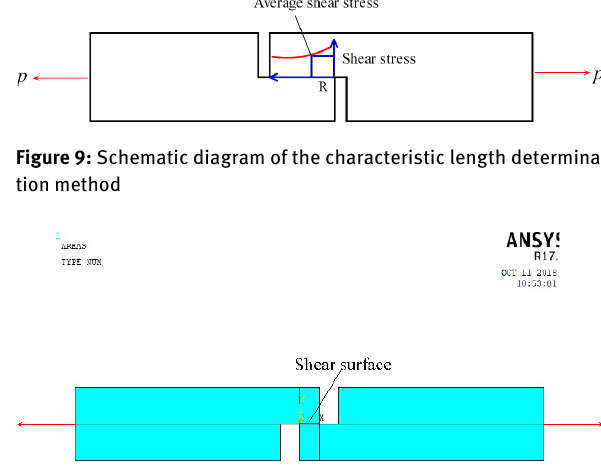
Figure 10: Finite element model of a double-notch shear specimen